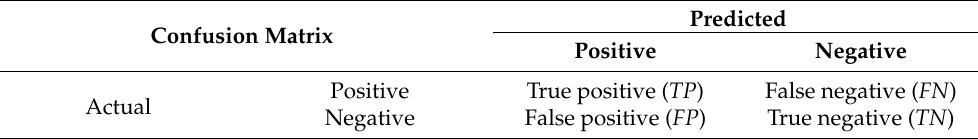
Table 3. Actual and predicted label confusion